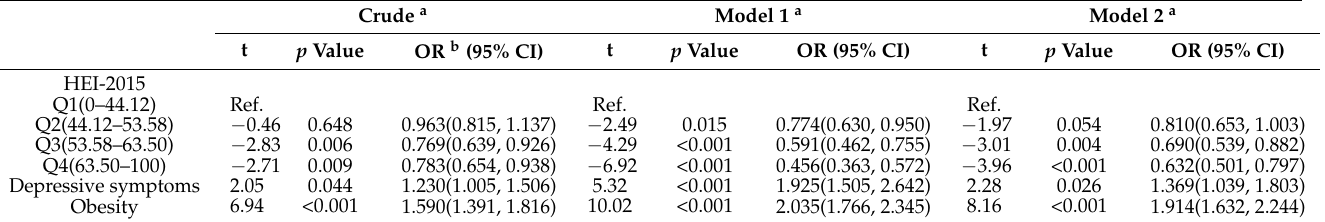
Table 2. Weighted odds ratios (ORs) with 95 percent confidence intervals (CIs) for the HEI-2015, obesity, depressive symptoms, and the risk of CVD. Crude a Model 1 a Model 2 a